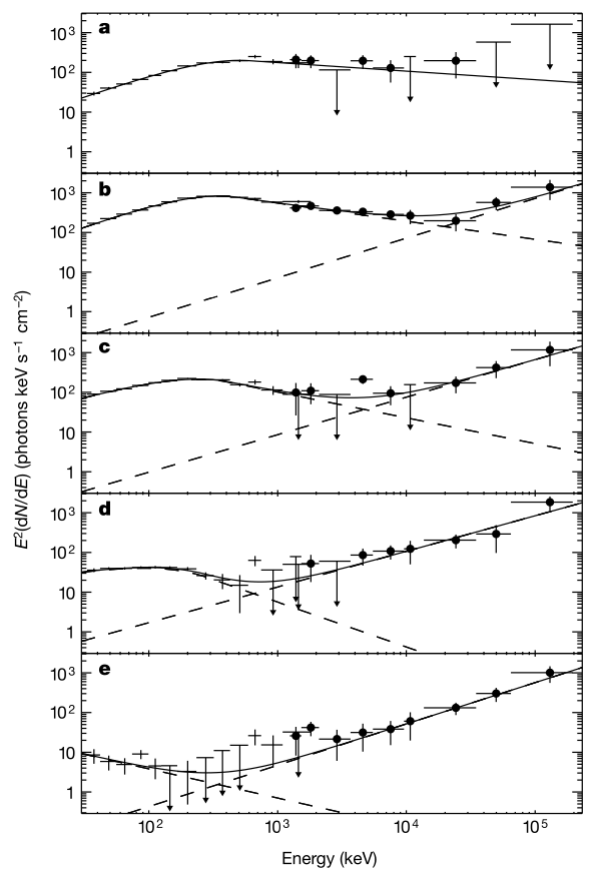
Figure 1. Gamma-ray spectra of GRB 941017. Five time intervals are shown in five separated panels, from the beginning of the prompt phase to more than 200s (panel a : 18–14s; b : 14–47s; c : 47–80s; d : 80–113s; e : 113–211s). Crosses and filled circles show BATSE and EGRET data, respectively. The model fit (solid curve) is composed by a superposition of a smoothly broken PL (Band model) and a PL function. Two distinct spectral component are clearly present, except in the first time interval. From